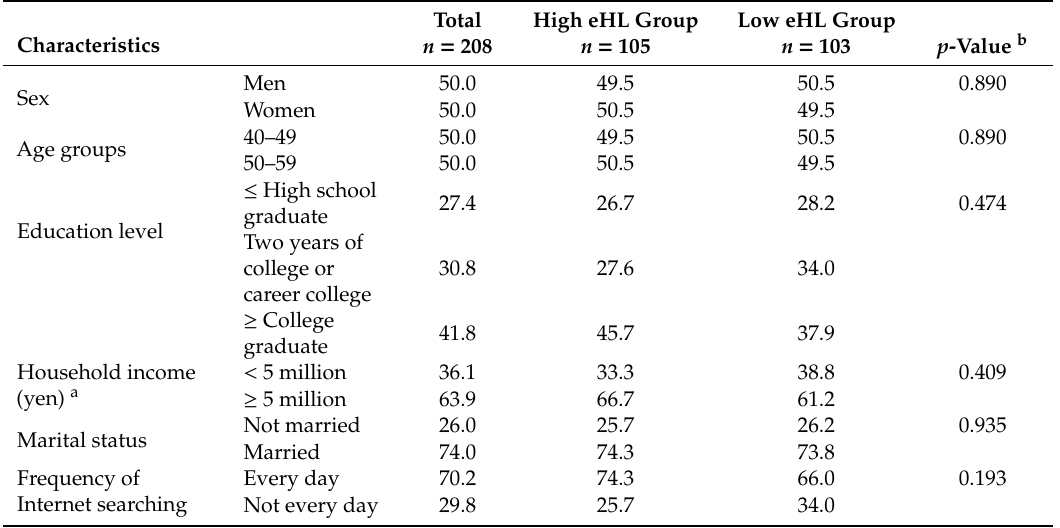
Table 1. Participant characteristics (%) in the high eHealth literacy (eHL) and low eHL groups.